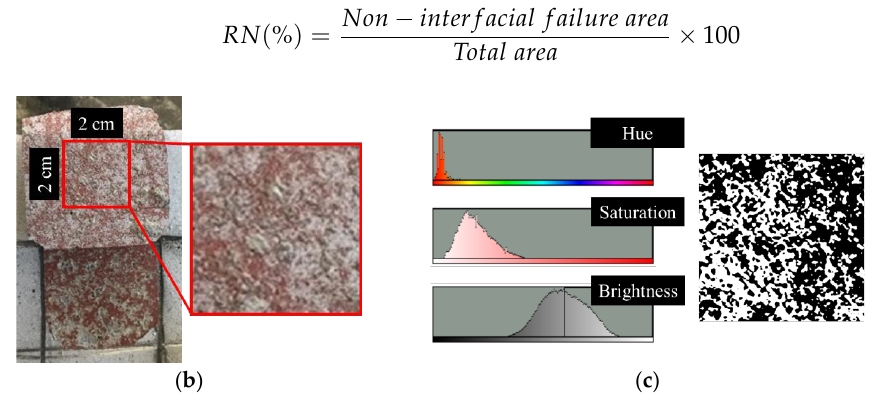
( b ) Figure 4. Schematic of the bonding strength measurement. ( a ) Top view; ( b ) Side view. 2.5.3. Image Analysis